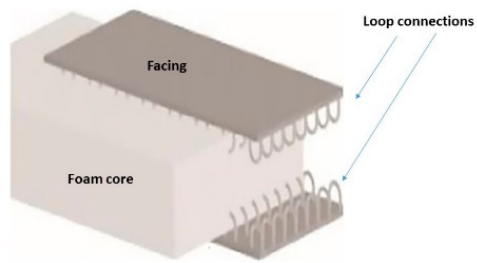
Figure 20. Structure concept of looped fabric reinforced foam composite (U-core). Adapted from [65].